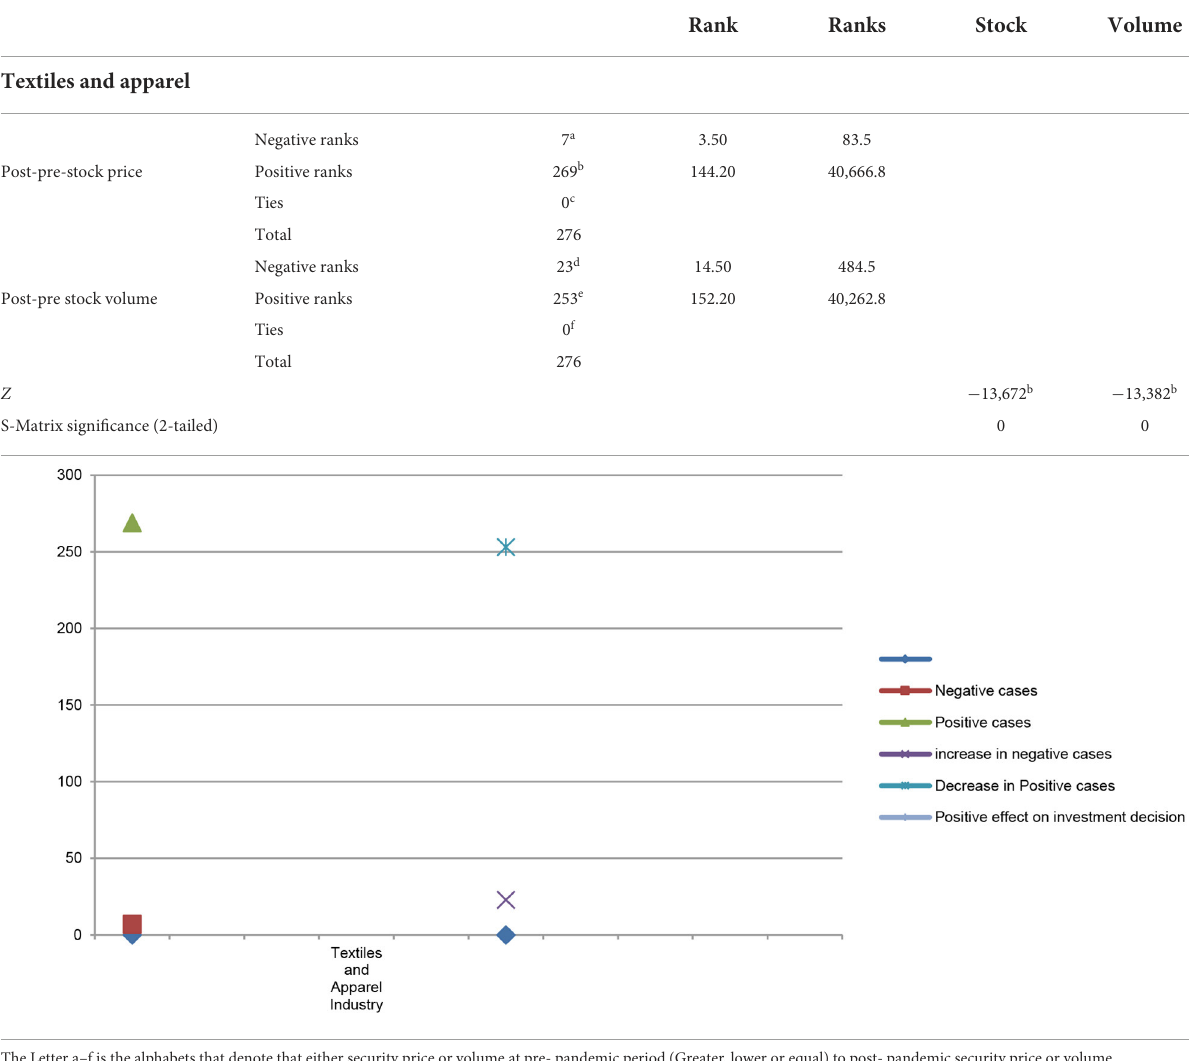
TABLE 7 Multiple regression of textiles and apparel